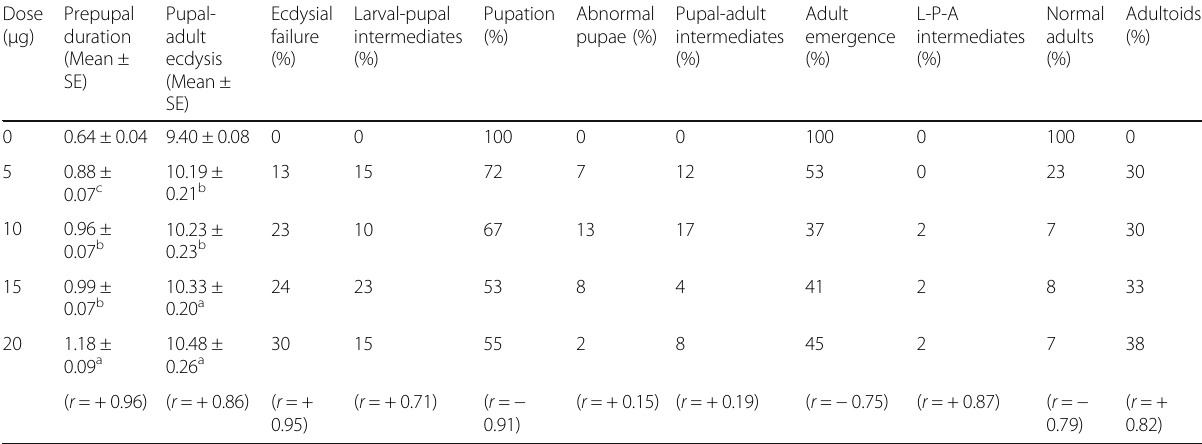
Table 4 Topical administration of root extracts of Withania somnifera on prepupal stage of Pericallia ricini ( n = 20; replicate = 3) Dose Prepupal ( μ g)